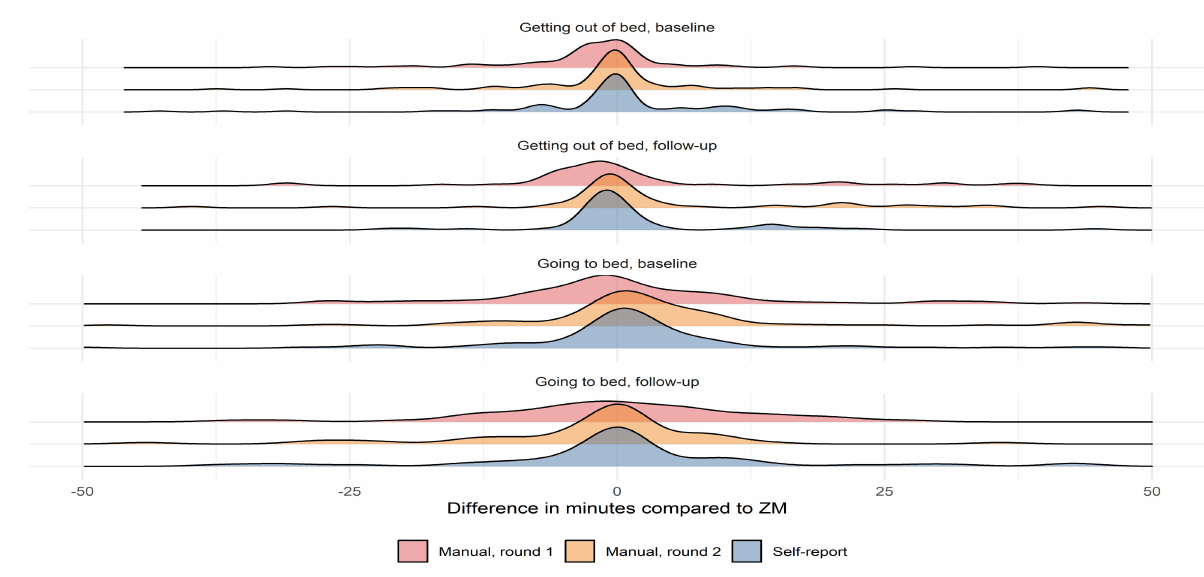
Figure 3. Probability density distributions for differences between manual in-bed annotations and self-report compared to